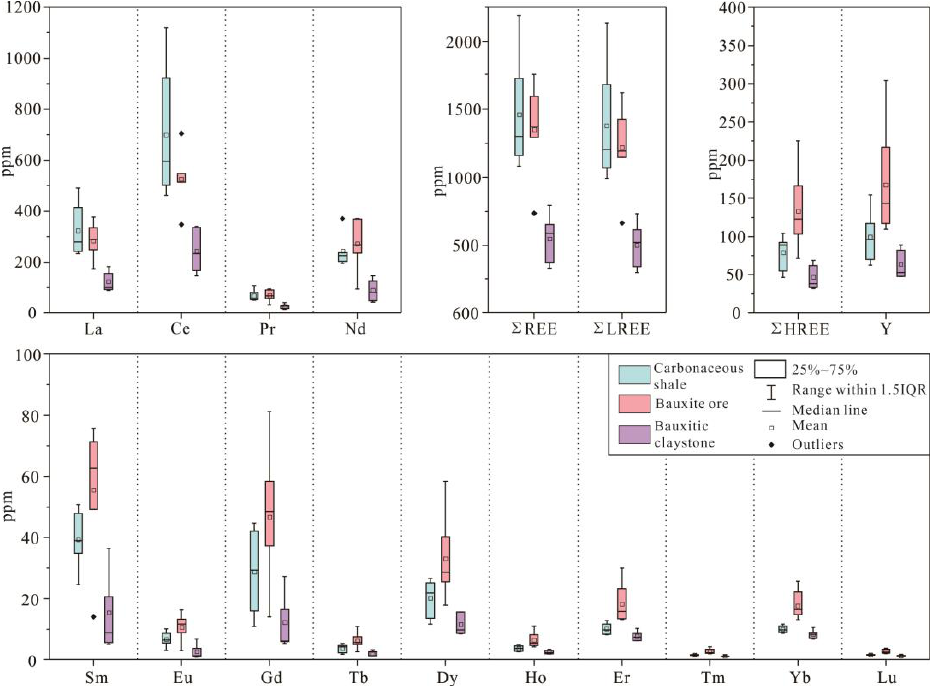
Figure 6. Boxplot of the rare earth elements contents in the bauxite ore, carbonaceous shale, and bauxitic claystone samples of the Lindai bauxite deposit (data from [28]).